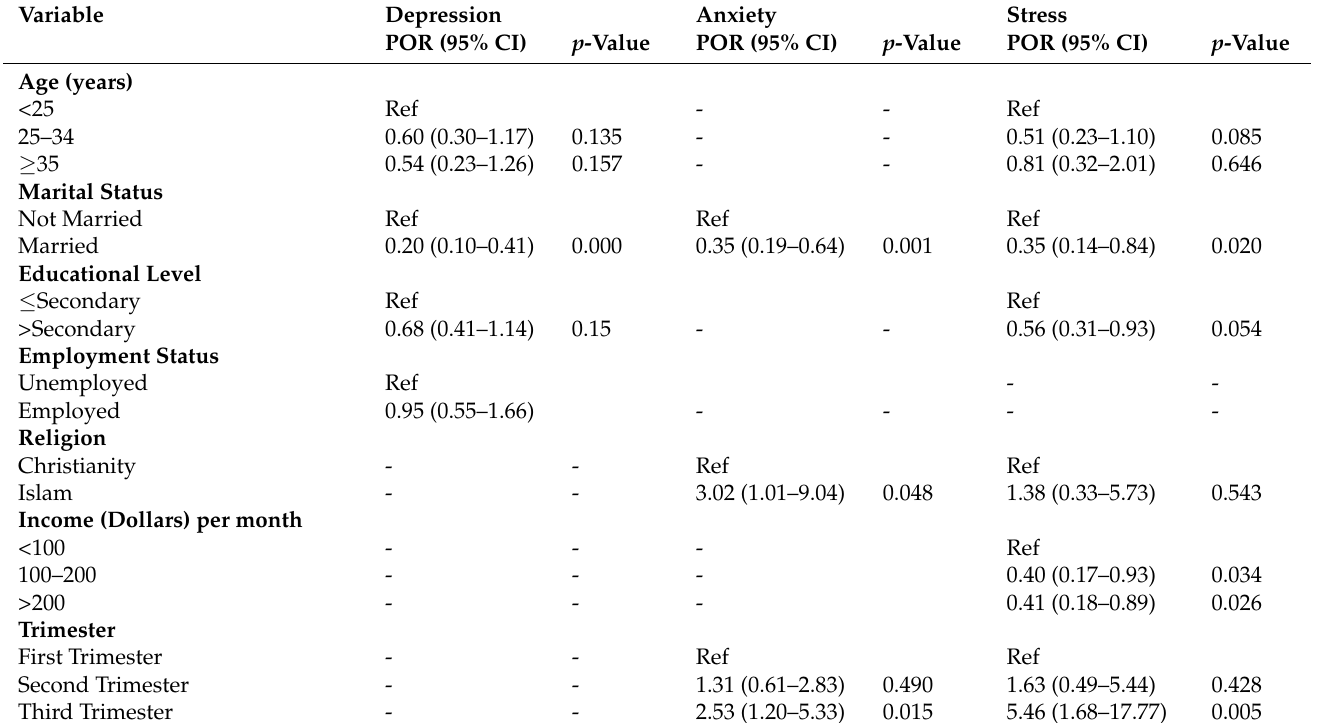
Table 6. Proportional odds model for factors affecting depression, anxiety, and stress among preg- nant